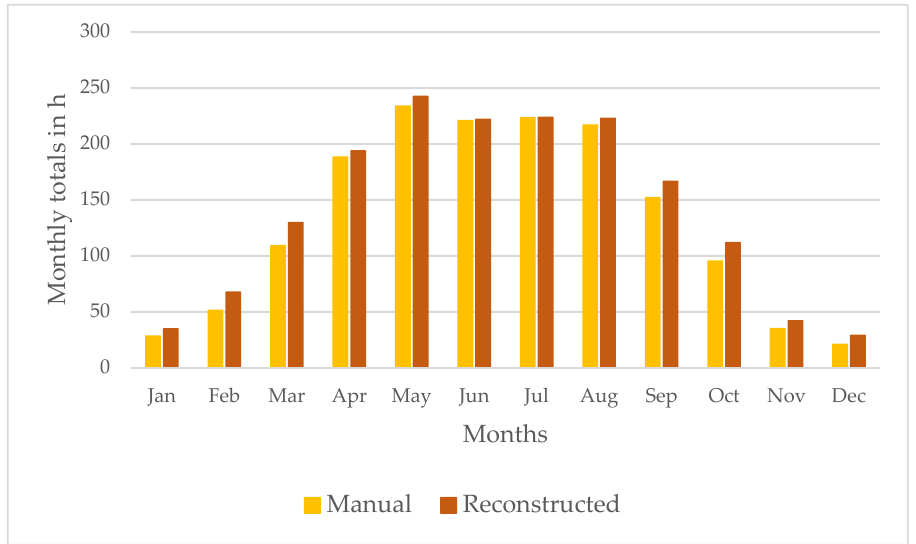
Figure 8. Measured and reconstructed monthly totals of sunshine duration in Borucino, 1991–2020.